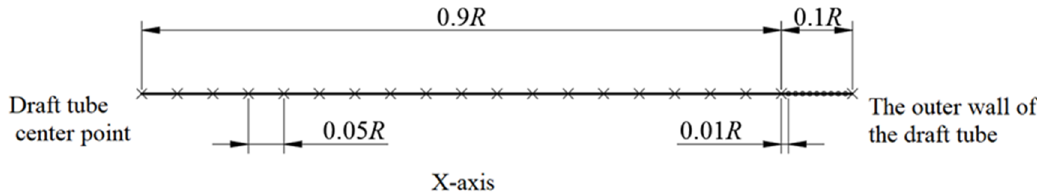
Figure 12. Test system. ( a ) Test location and ( b ) test window drawings.